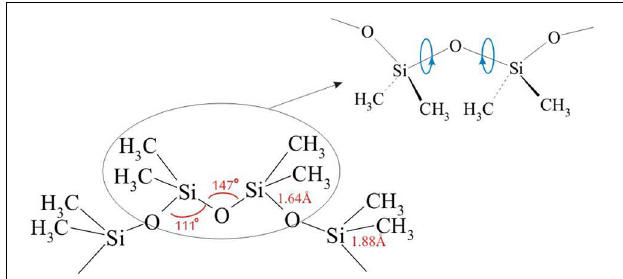
FIGURE 4 | Example of siloxane chain.